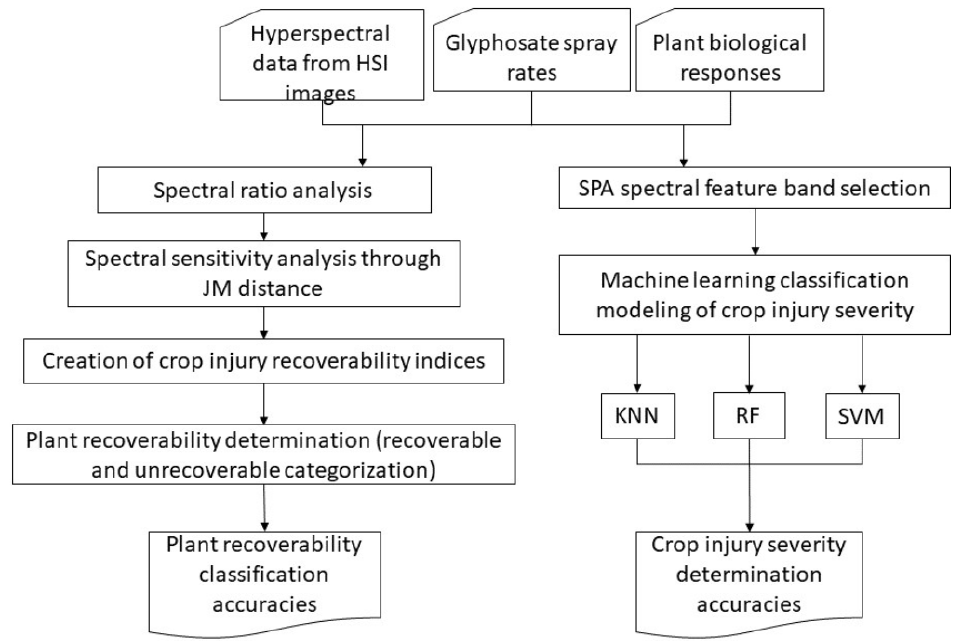
Figure 4. Workflow of data processing and analysis in this